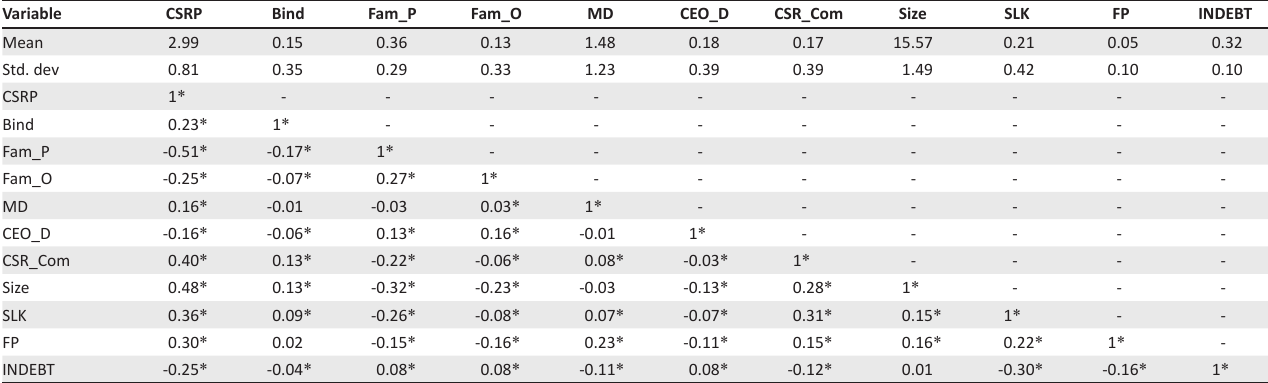
TABLE 1: Means, standard deviations and Pearson’s correlations for regression variables.